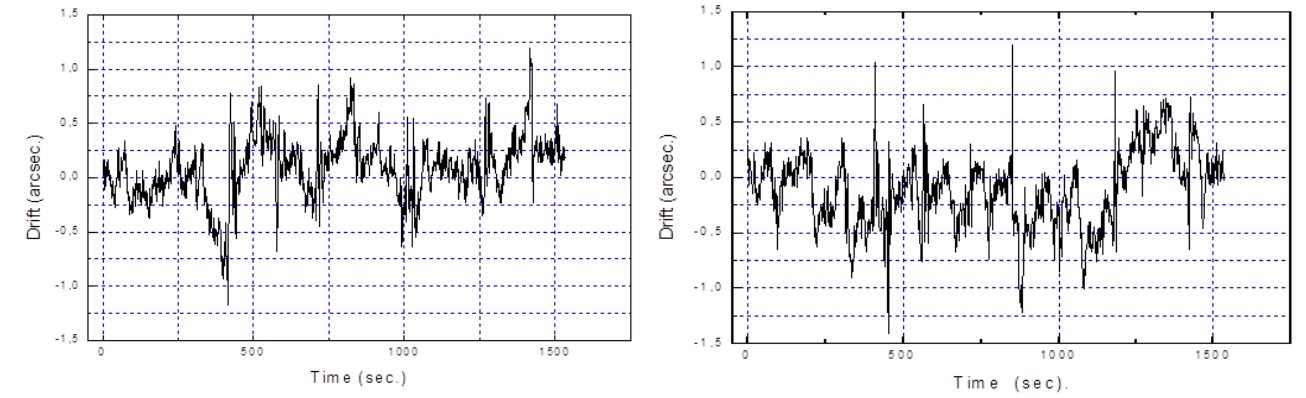
Figure 4. Drift of the star image center along X axis ( left ) and Y axis ( right ).